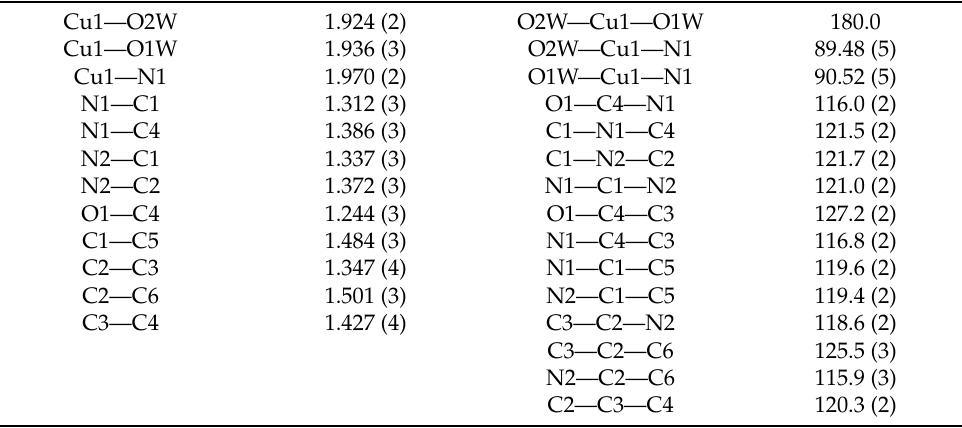
Table 2. Selected bond distances and angles (Å, ◦ ) in complex ( 1